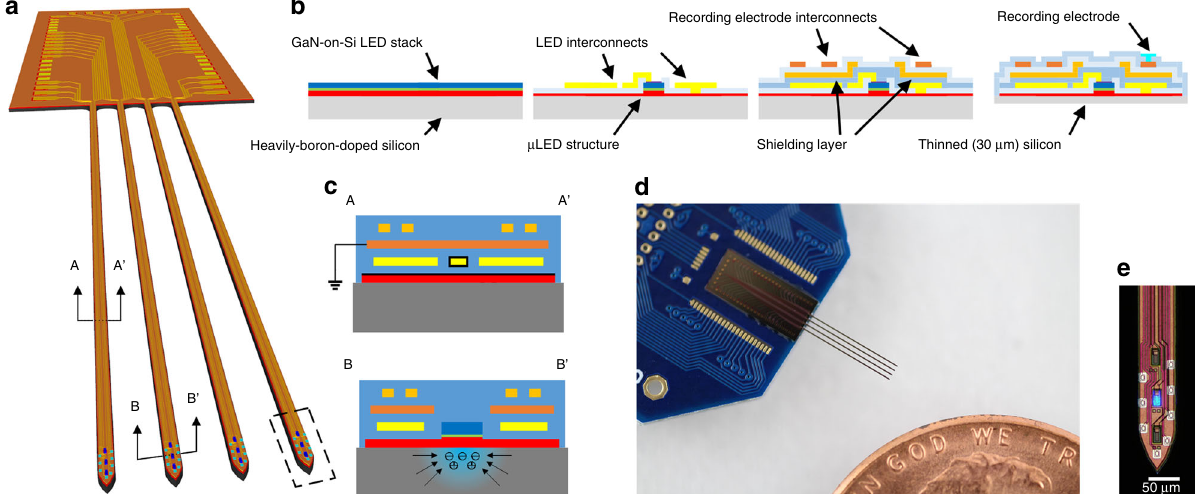
Fig. 1 MiniSTAR optoelectrode. a Schematic illustration of a miniSTAR μ LED optoelectrode. b Simpli fi ed miniSTAR optoelectrode fabrication process. An illustrative cross-section containing only one LED and one recording electrode is shown. c Cross-sectional schematic diagrams of a shank of a miniSTAR optoelectrode, showing sources of stimulation artifact (EMI and PV effect for top and bottom, respectively) and methods for reduction of stimulation artifact. d Photograph of a miniSTAR optoelectrode mounted on a PCB. e Microphotograph of a tip of a miniSTAR optoelectrode, on which eight recording electrodes, three LEDs, LED interconnects, shielding layer, and recording electrode interconnects are